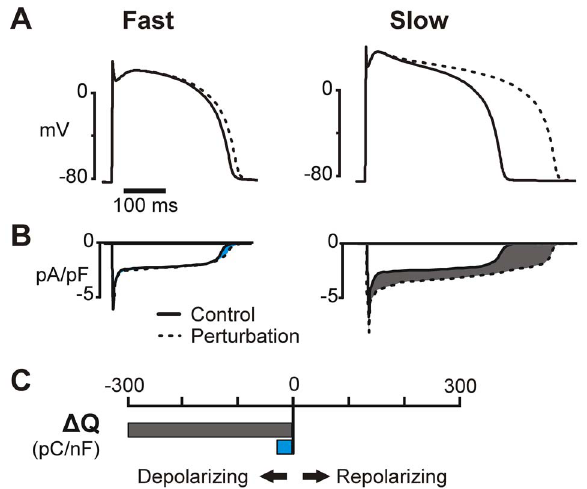
Figure 7. Quantitative contributions of individual ionic cur- rents to AP rate dependence. ( A ) Hypothetical APs before (solid) and after a perturbation that causes RRD prolongation of the AP. ( B ) A specific hypothetical ionic current under the conditions shown in ( A ). This inward (i.e. depolarizing) current increases with the perturbation at the slow rate (gray shaded area) but barely changes at the fast rate (blue shaded area). ( C ) D Q is the integral of the difference in current between control and perturbation (shaded areas in ( B )) in units of pC/ nF. The large, negative D Q at slow pacing (gray bar) indicates that this current will prolong the AP at this rate, whereas the small, negative D Q at fast pacing (blue bar) indicates a minimal alteration of the AP at this rate. This current will therefore contribute to RRD AP prolongation. Figure S4 shows additional hypothetical examples of D Q that can contribute to either RRD or FRD